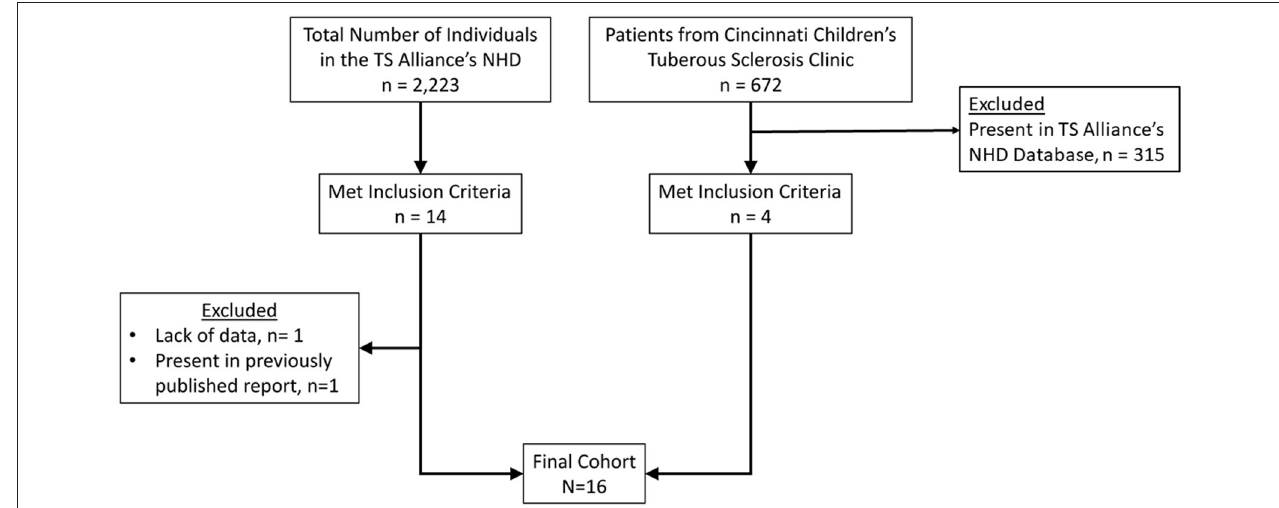
FIGURE 1 | Study flow chart and patient selection process.